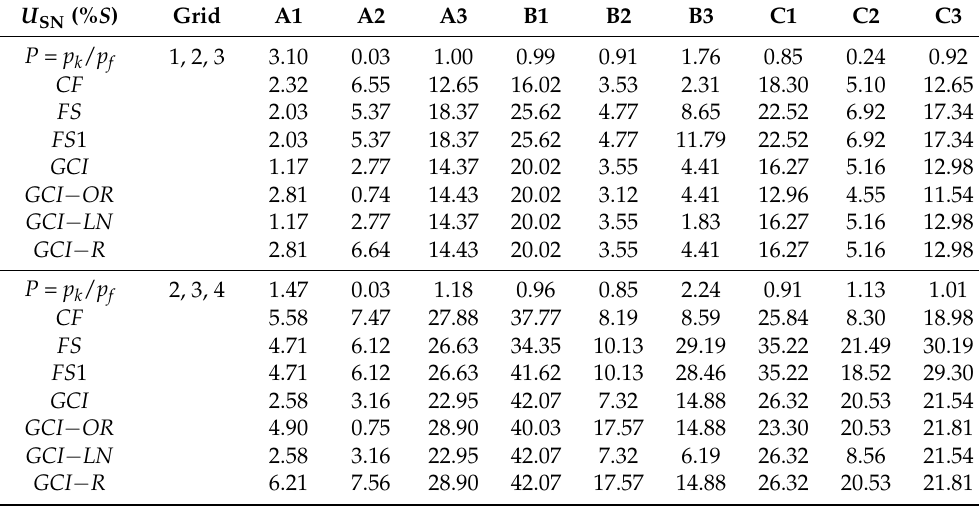
Table 3. Uncertainty estimation of seven estimators for concentrations.